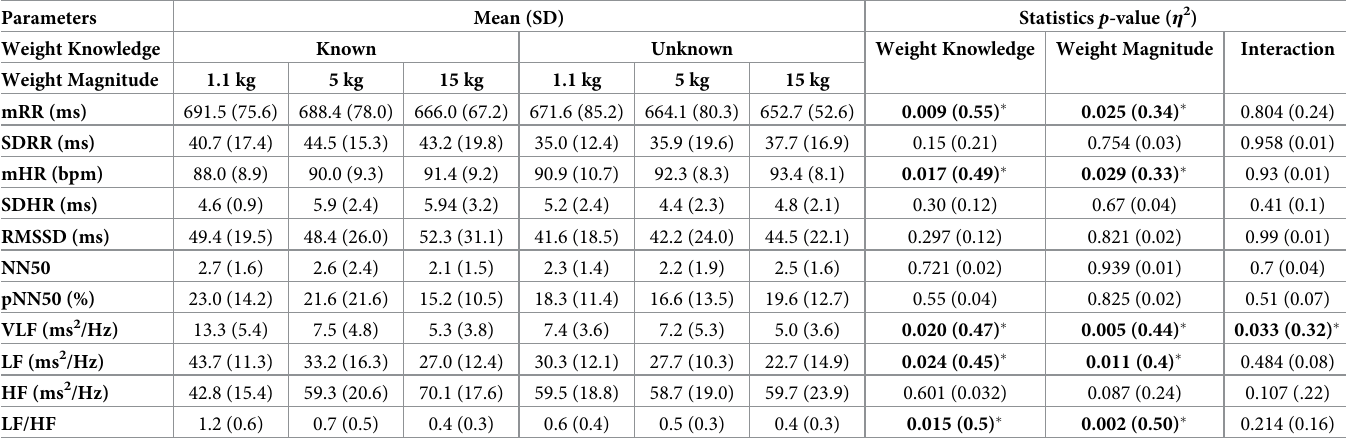
brain [F(1,9) = 5.55, p < 0.043, η 2 = 0.38], where lifting unknown weights was associated with a smaller α band PSD. In addition, weight knowledge had a significant effect on the β band PSD Table 2. Means, Standard Deviations (SD), p-values, and effect sizes ( η 2 ) of the Heart Rate Variability (HRV) indices.